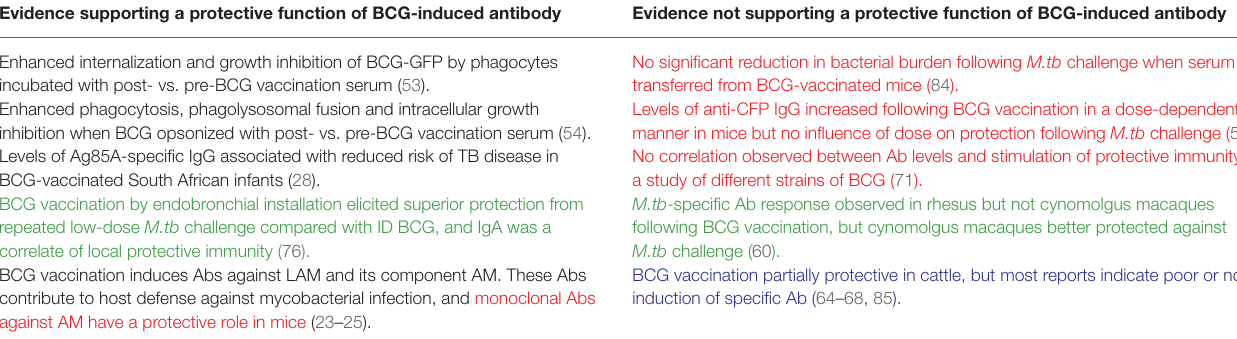
TABLE 2 | Summary of studies discussed in this review providing evidence for or against a protective function of BCG-induced antibodies. Evidence supporting a protective function of BCG-induced antibody Evidence not supporting a protective function of BCG-induced antibody Enhanced internalization and growth inhibition of BCG-GFP by phagocytes incubated with post- vs. pre-BCG vaccination serum